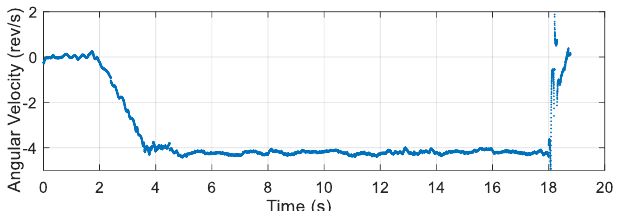
Figure 17. Scanning angular velocity of the airdrop experiment.